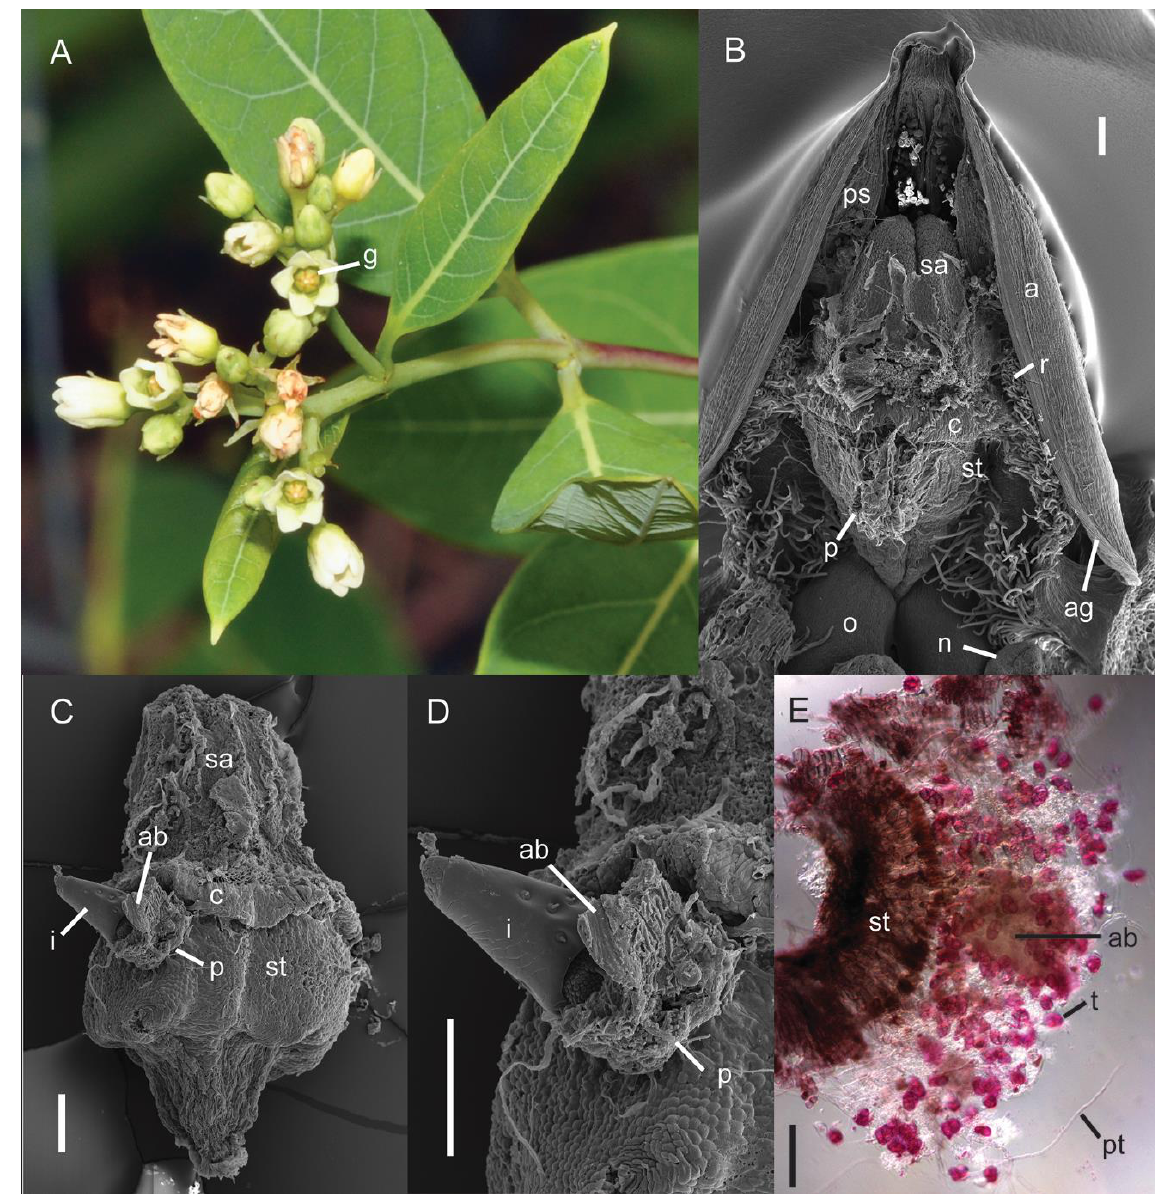
F IGURE 1. Apocynum cannabinum. A. Inflorescence with flowers at anthesis showing the gynostegium (g). B. Gynostegium with two anthers removed to show pollen clump (p) on the stigma (st); the anthers (a) are adnate to the collar (c) of the style- head via adaxial pads of hairs,